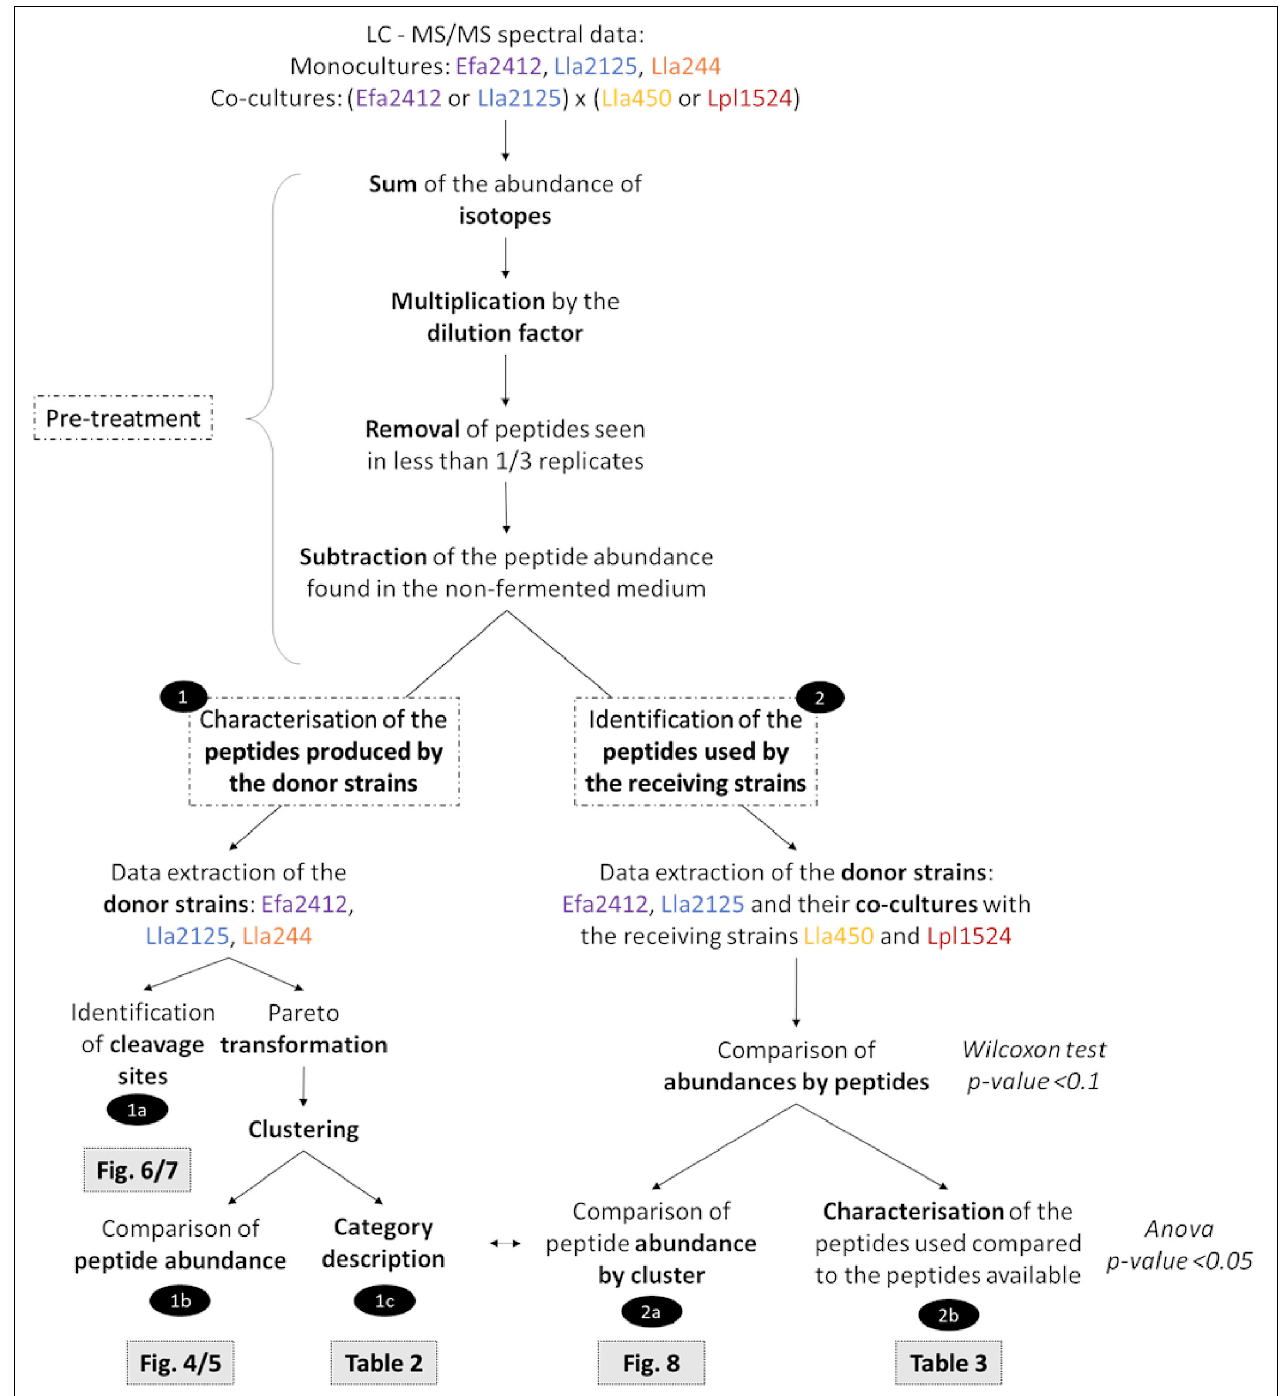
FIGURE 2 | Workflow of the data treatment realized to compare the proteolytic profile of the three donor strains and to establish the characteristics of the peptides potentially involved in the interactions with the receiving strains.